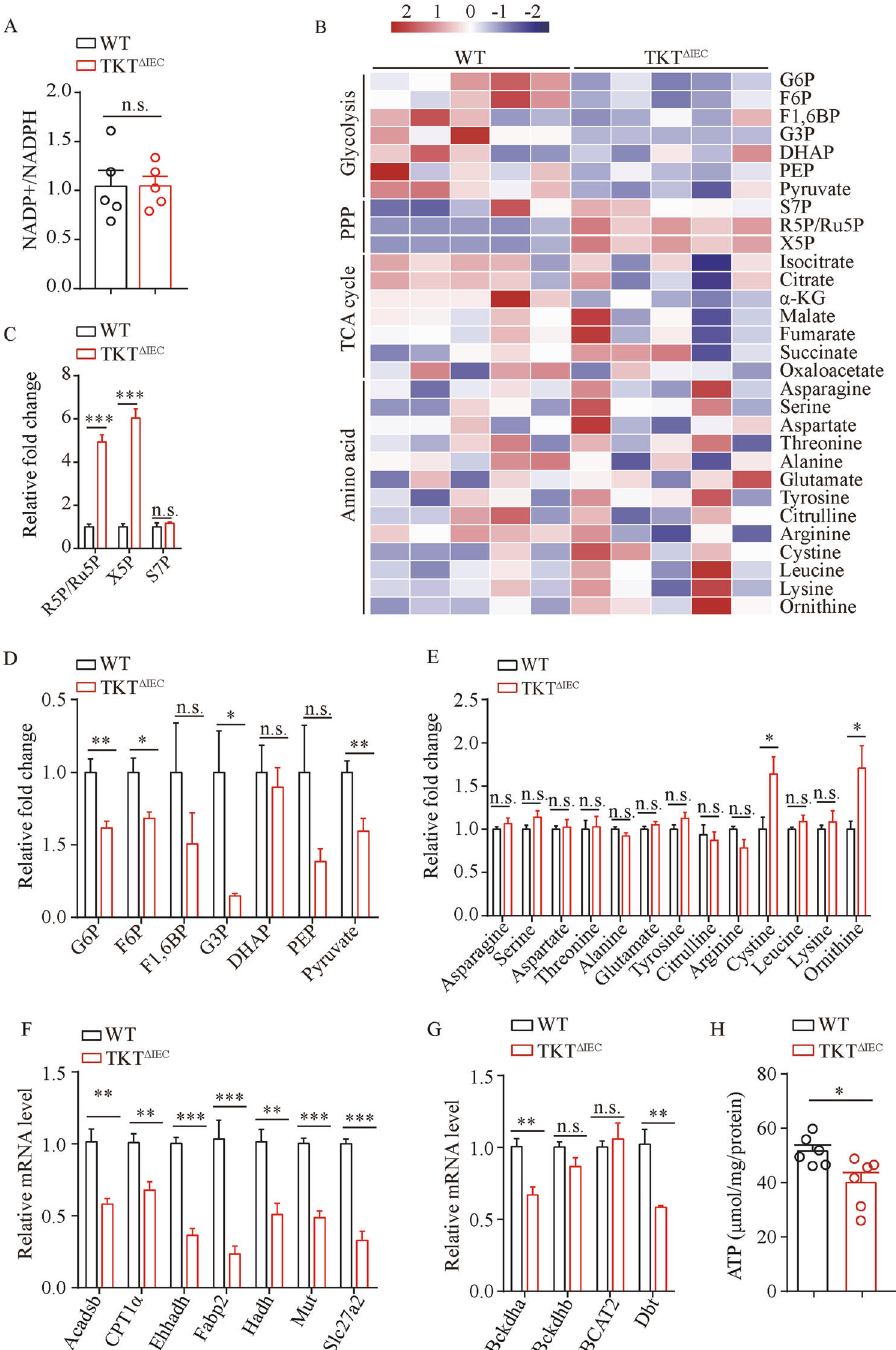
Fig. 7 Loss of TKT causes insuf fi cient energy supply in the intestine. A NADP + /NADPH levels in colons of 3-week-old WT and TKT Δ IEC mice ( n = 5). B Heat map of metabolites in glycolysis, PPP, TCA cycle and amino acids in colons of 4-week-old WT and TKT Δ IEC mice. C Relative levels of PPP metabolites in colons of 4-week-old WT and TKT Δ IEC mice ( n = 5). D Relative levels of glycolytic metabolites in colons of 4-week-old WT and TKT Δ IEC mice ( n = 5). E Relative levels of amino acids in colons of 4-week-old WT and TKT Δ IEC mice ( n = 5). F QPCR analysis of mRNA levels of FAO-related genes in colons of 3-week-old WT and TKT Δ IEC mice ( n = 5). G QPCR analysis of mRNA levels of enzyme genes for BCAA catabolism in colons of 3-week-old WT and TKT Δ IEC mice ( n = 5). H Levels of colonic ATP of 3-week-old WT and TKT Δ IEC mice ( n = 6). Data are represented as mean ± SEM. Signi fi cance is determined by Student ’ s t test analysis, * P < 0.05, ** P < 0.01, *** P <